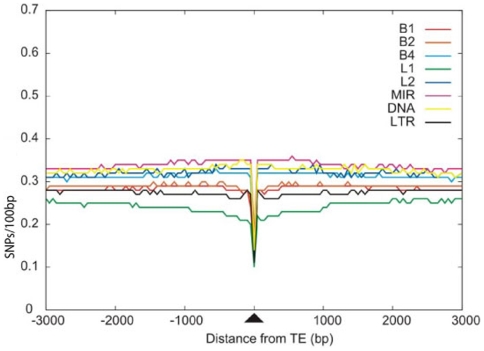
Density of SNPs within all transposed elements in the mouse genome.The average SNP frequency in the TE and the flanking sequence is shown in a sliding window of 50 bp. All frequencies are normalized to a frequency per 100 bp. The center of the TE is located at position 0.